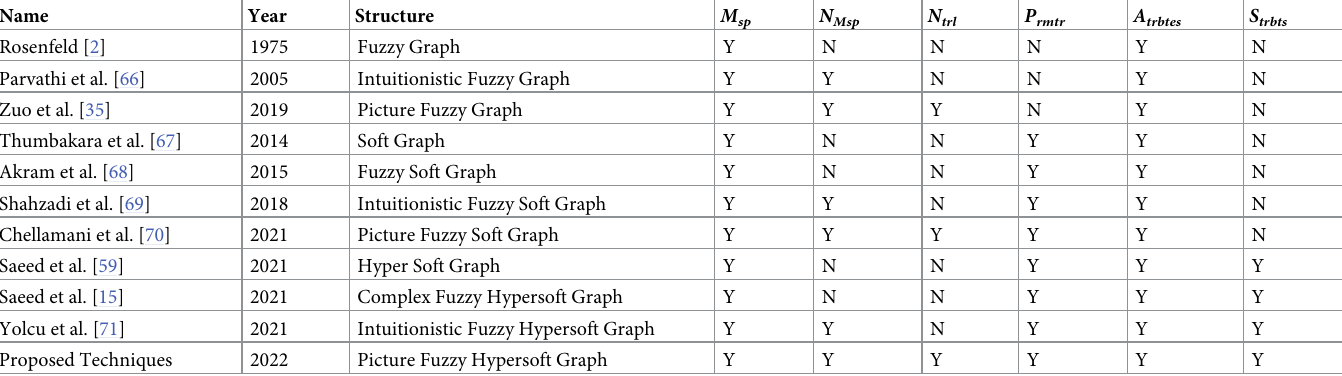
Table 4. Comparison between PFHSG and some existing fuzzy graph